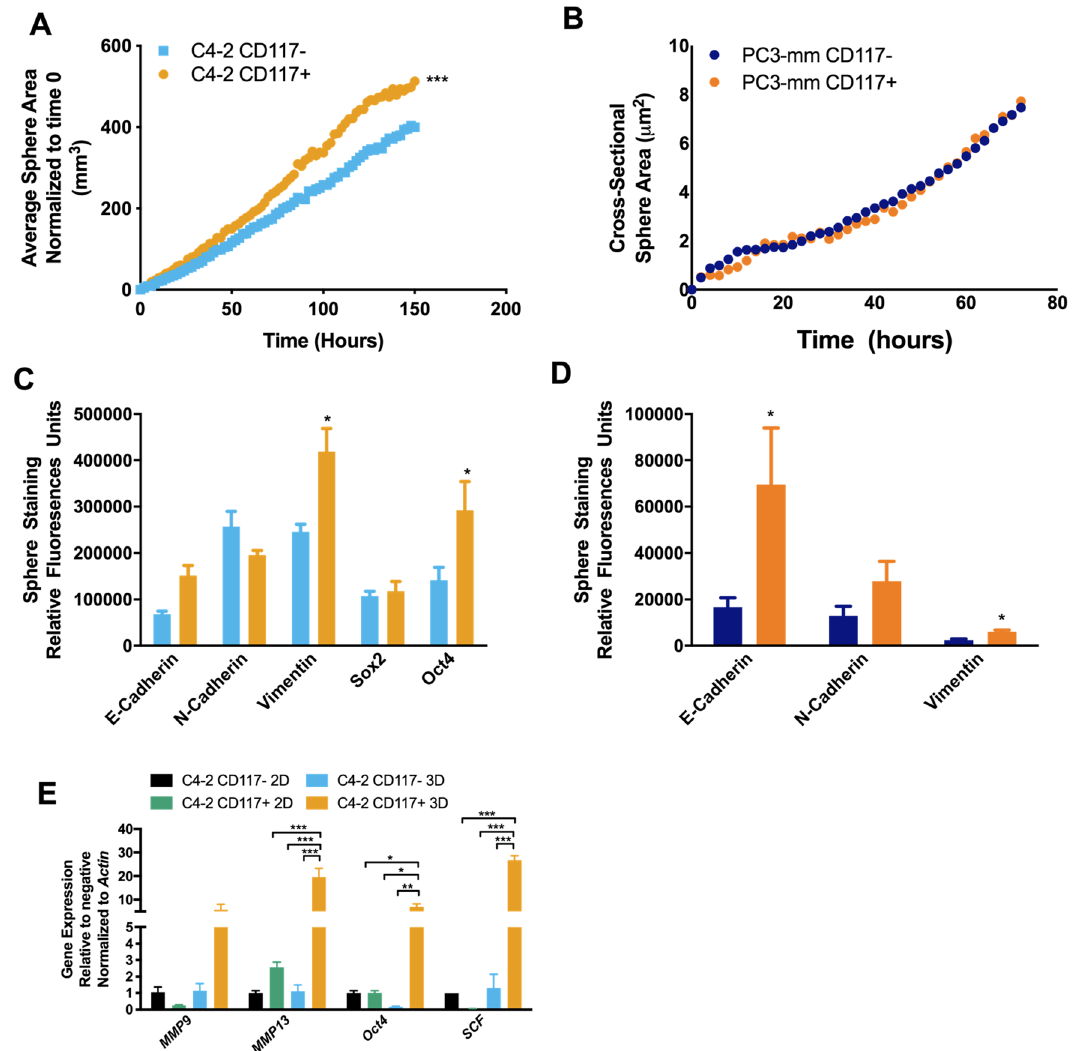
Figure 3. CD117 promotes aggressiveness in three-dimensional culture. C4-2 ( A and C ) and PC3-mm ( B and D ) cells were sorted into CD117+ and negative populations. ( A and B ). Sphere formation was tracked using live- cell imaging and represented as mean sphere area ( n = 12). ( C and D ) After 7 days, spheres were sectioned and stained for the EMT markers: E-cadherin, N-cadherin, and vimentin; and ( C ) the stemness markers: Sox2 and Oct4. Relative fluorescence is represented as mean ± SEM ( n = 3–6). ( E ) Gene expression was compared between C4-2 sorted cells grown in 2D monolayer or 3D spheres and represented as mean fold change ± SEM ( n = 3). *Represents p < 0.05, **represents p < 0.01, and ***represents p < 0.005 by Student’s t test ( A – C ) and one-way ANOVA ( D